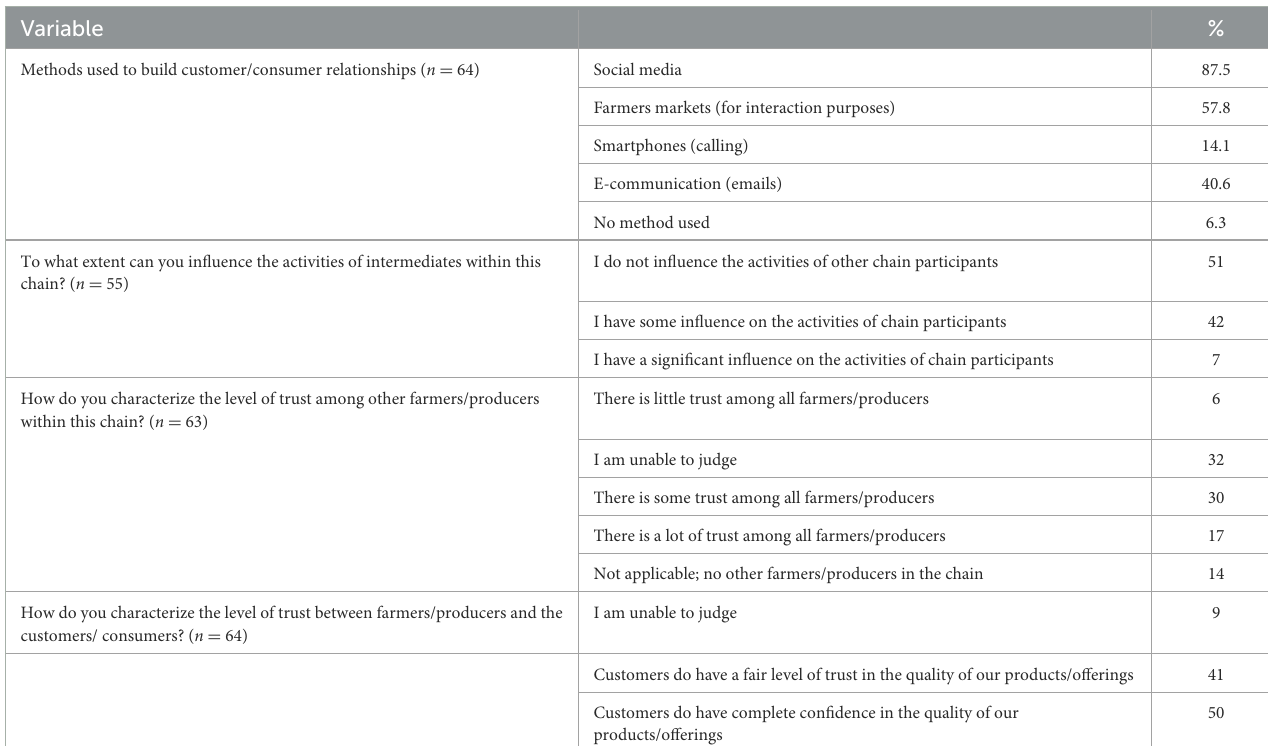
TABLE 3 Information sources and the level of trust in SFSCs. Variable Methods used to build customer/consumer relationships ( n =